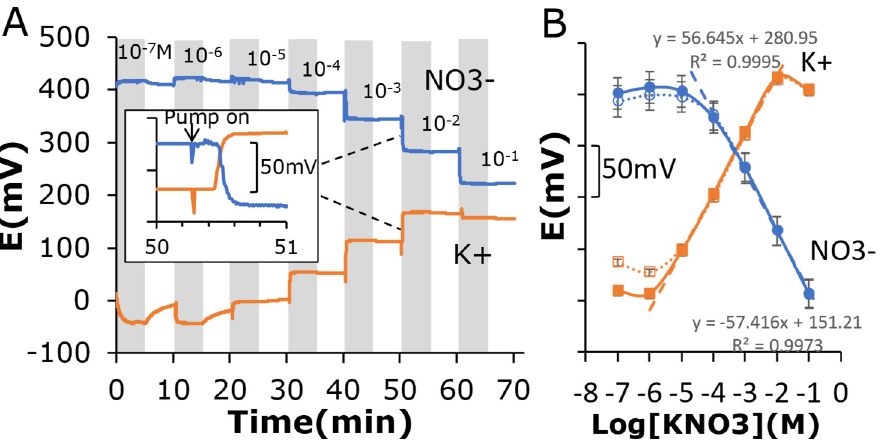
Figure 4. Potentiometric response of the multiplexed sensor (K + and NO 3 − electrodes and Ag/AgCl reference) in microchannel under alternating flow (shaded) and static conditions: ( A ) Real-time sensor response. Flow rate: 0.45 mL/min. Electrolyte: KNO 3 + 10 mM NaCl. Inset: enlarged view showing sensor’s response to changing concentration. ( B ) Calibration curves of the NO 3- and K + ISEs (3 electrodes for each ion). Solid lines indicate flow condition and dashed lines indicate static condition.